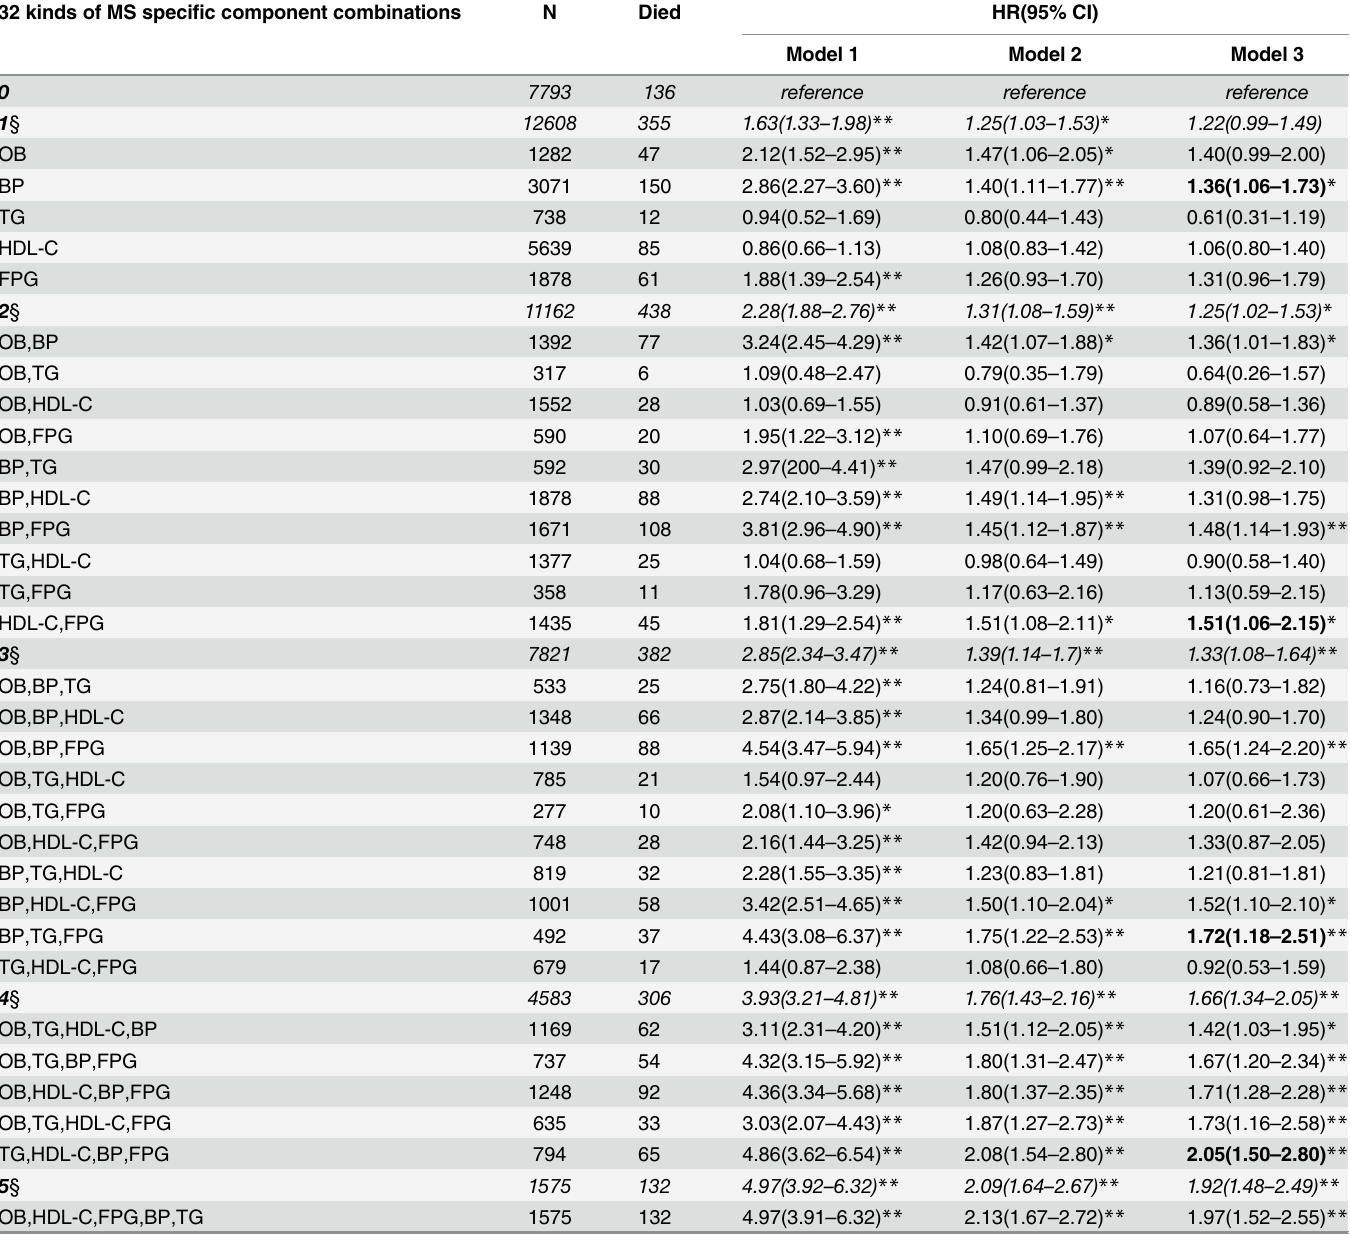
Table 5. All-cause mortality associated with 32 kinds of MS specific component